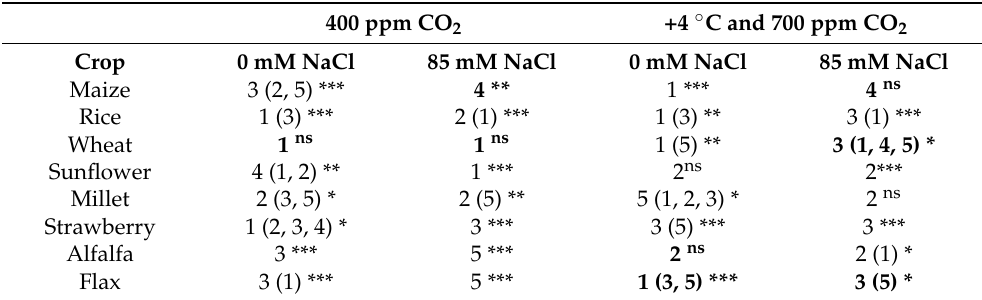
Figure 1. Effects of biofertilizers on the growth of different crops. ( A ) Maize plants inoculated with rhizobacteria consortia, numbered from 1 to 5, grown at 400 ppm CO 2 and ( B ) at +4 °C and 700 ppm CO 2 , with (+) and without ( − ) 85 mM NaCl. Number 0 was used for non ‐ inoculated controls. ( C ) Sunflower plants grown at 400 ppm CO 2 and ( D ) at +4 °C and 700 ppm CO 2 with (+) 85 mM NaCl. In the top of panels C and D, there are photographs taken by the plant ‐ imaging system NightShade LB 985 (leaves of the same age were used, taken in the middle of the stem). The color scale mirrors the detected counts per second (cps) of delayed fluorescence emission in leaves: the redder, the less stressed the leaf is. The absence of color indicates that the leaf was dead. ( E ) Alfalfa plants grown at 400 ppm CO 2 and ( F ) at +4 °C and 700 ppm CO 2 , with (+) and without ( − ) 85 mM NaCl. Table 2. Biofertilizers that generated the highest production of above ‐ ground biomass for each crop under the different treatment conditions.